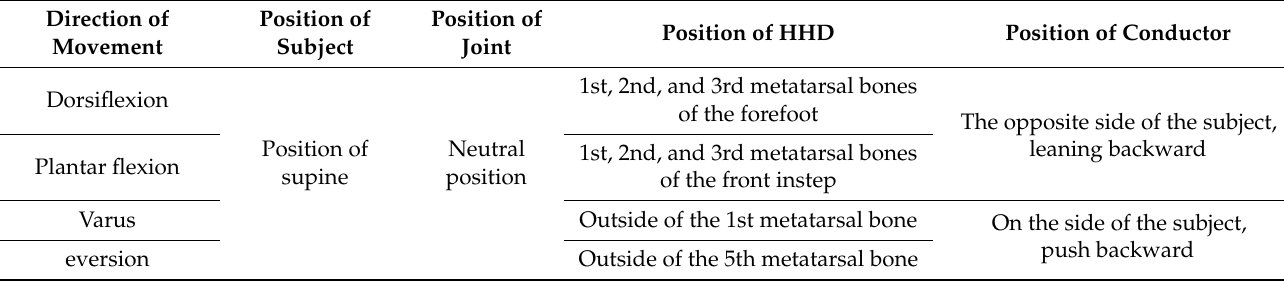
Table 1. The details of the